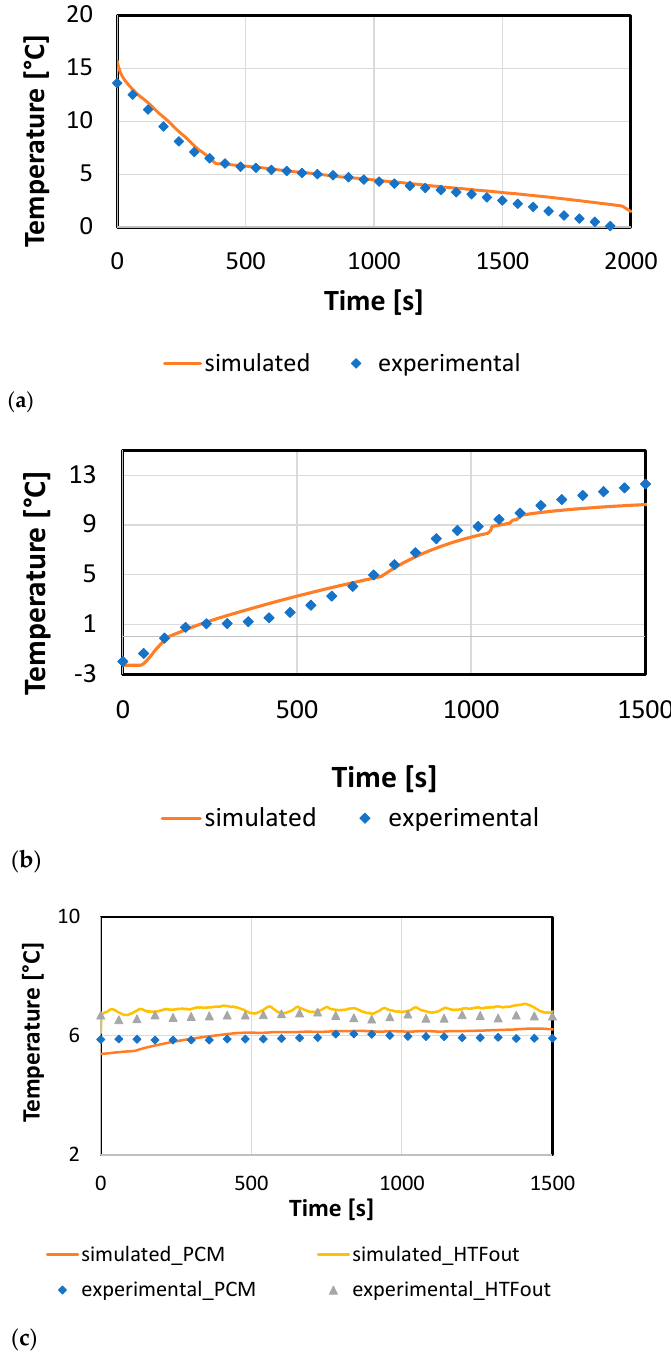
Figure 4. Model validation for the different operating modes. ( a ) charge; ( b ) discharge; ( c ) parallel operation.